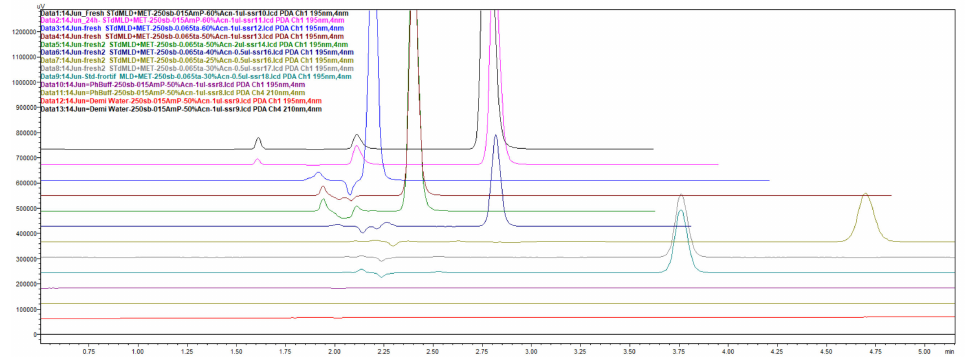
Figure 49. The short summary overview of created chromatograms of sample with 2.5 mg/mL meldonium and 0.5 mg/mL metoprolol, with different percentages of ACN and different inorganic part composed of 0.065% TFA or 15 mM NH 4 H 2 PO 4 were presented for comparison in overlaid mode, performed on Zorbax CN-SB 250 × 4.6